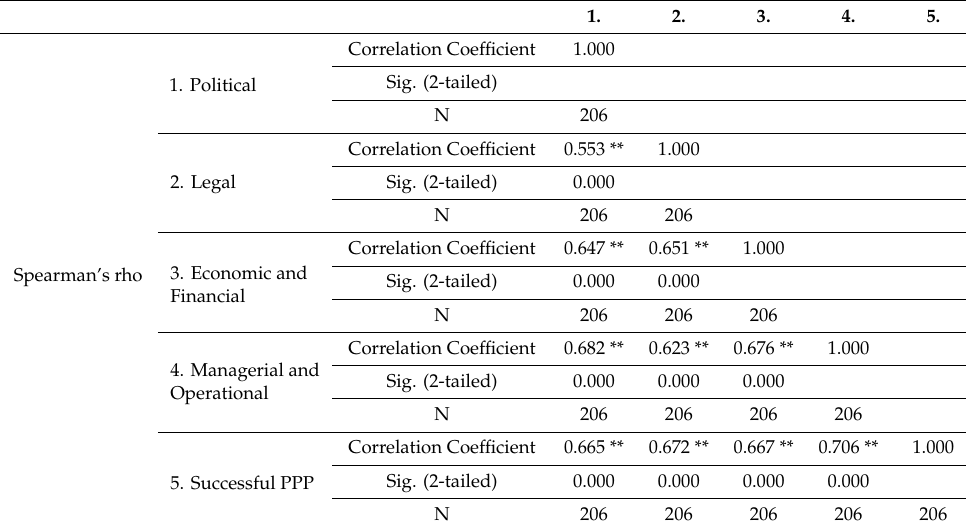
Table 10. Correlation matrix between independent variables and successful